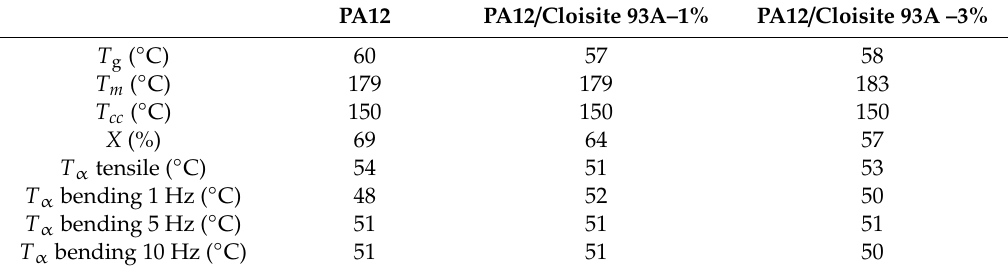
Table 5. Di ff erential scanning calorimetry (DSC)